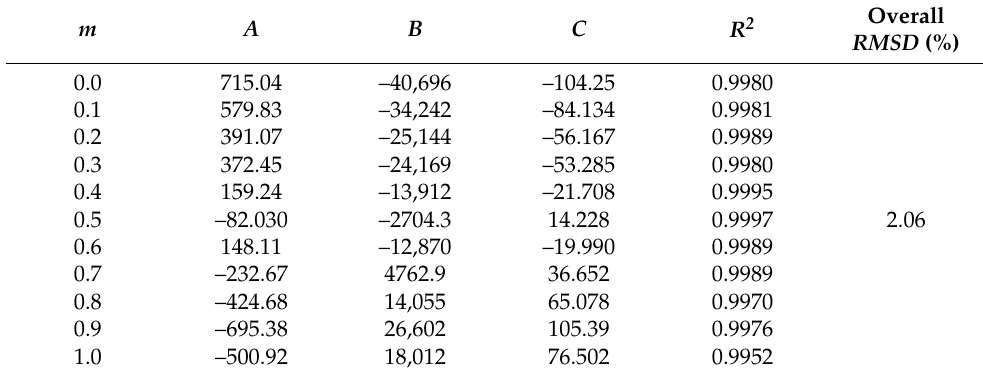
Table 6. Results for the Apelblat model for FXT (3) in several {PEG 400 (1) + H 2 O (2)} combinations.